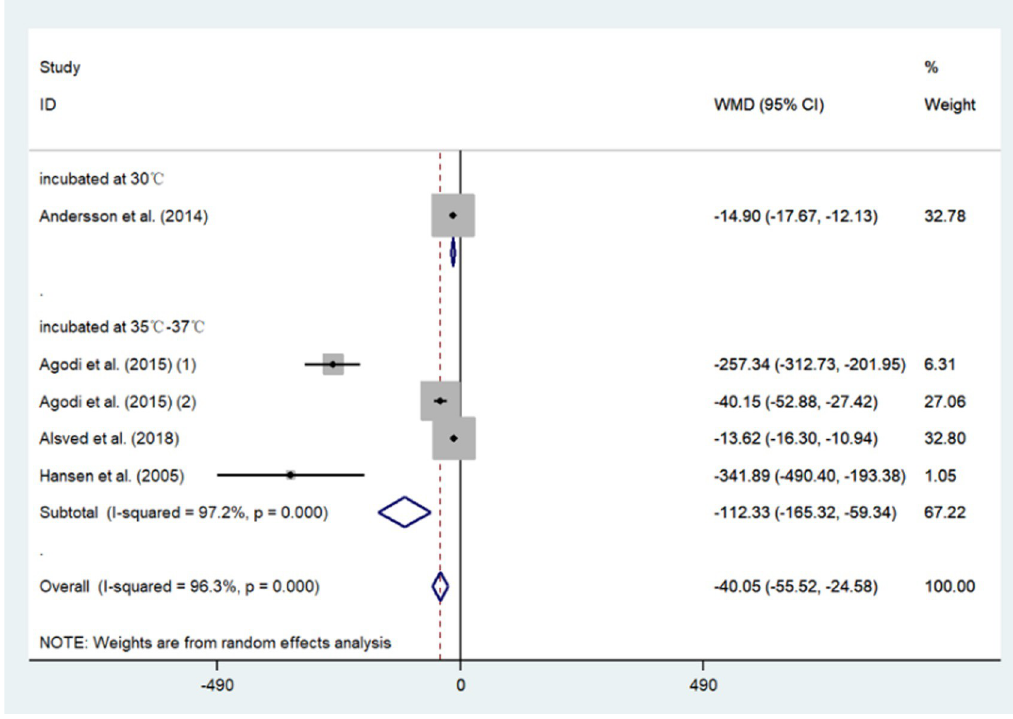
Fig 6. Forest plots of comparing the mean bacterial colony forming units per cubic meter (CFU/m 3 ) in OTs with LAF vs OTs without